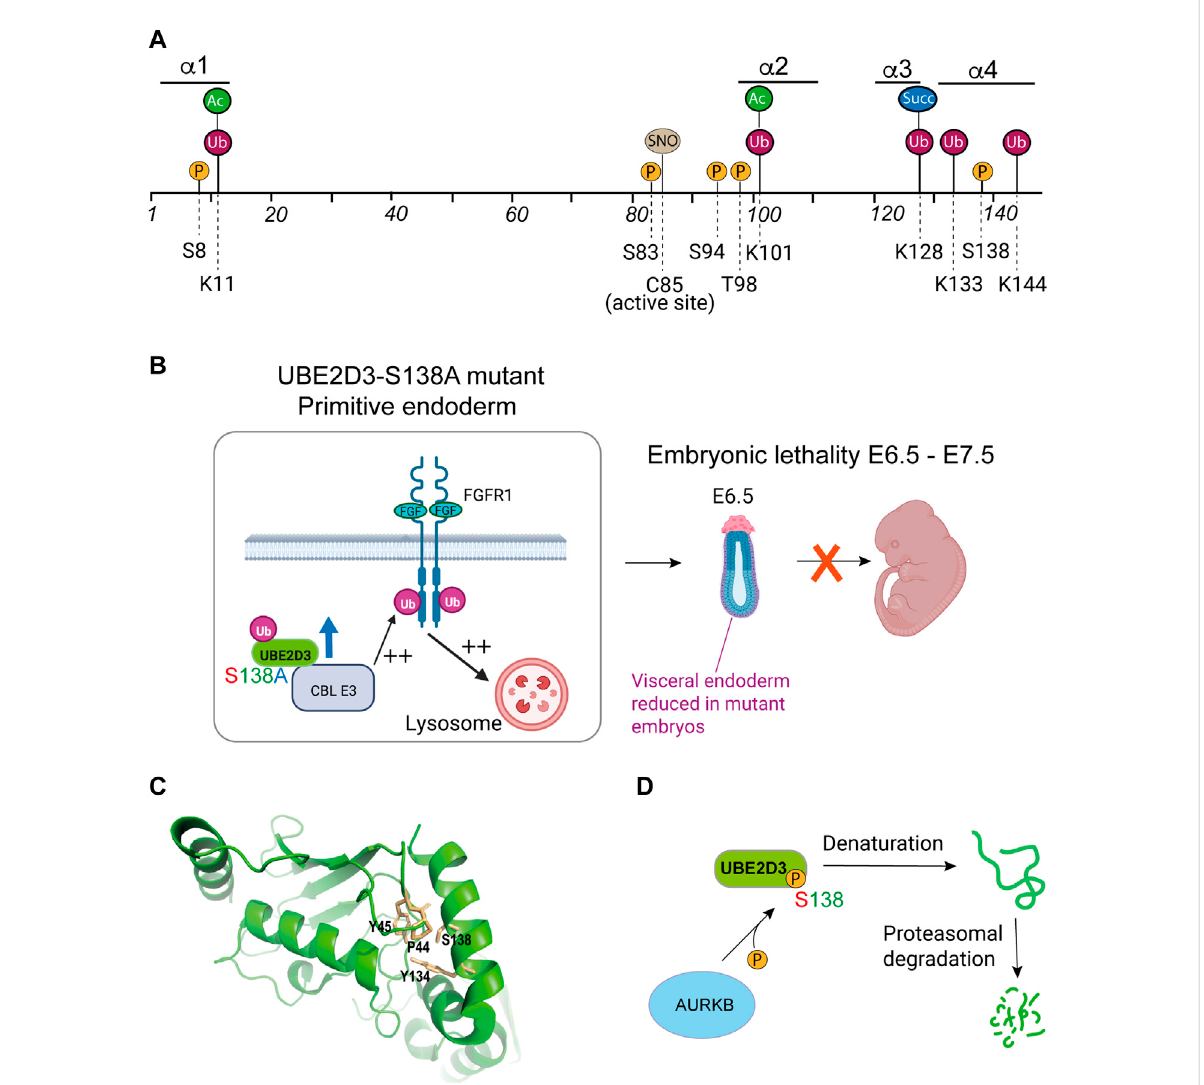
Role of post-translational modi fi cations (PTMs) in the regulation of UBE2D enzymes. (A) Residues in mammalian UBE2D that have been shown tobetargetsforPTMs.P=phosphorylation;Ub=ubiquitination;Ac=acetylation;Succ=succinylation;SNO=S-nitrosylation.Numbersindicatethe positions ofaminoacidresidues.InformationonPTMswasobtained fromPhosphoSite ® (Hornbecketal.,2015),withtheexceptionofS-nitrosylation of Cys85 (C85) (Valek et al., 2019; Fujikawa et al., 2020) and phosphorylation of UBE2D3-Ser138 (Roman-Trufero et al., 2020). (B) Phenotypic effects of the S138A mutation during early mouse development. Substitution of the amniote-speci fi c Ser138 residue with the alanine residue that is foundatthispositioninnon-amniotespeciesresultedina3-foldincreaseinthelevelofUBE2D3.Indevelopingprimitiveendoderm(PrE),thisresults in increased ubiquitination of fi broblast growth factor receptor 1 (FGFR-1) by the CBL E3 ligase, which uses UBE2D3 as a ubiquitin donor. EnhancementofFGFR1ubiqitinationcausesincreasedtraf fi ckingofthereceptortothelysosomeleadingtodownregulationofFGFR1signalling.This results in reduced levels of PrE and visceral endoderm and a high penetrance embryonic lethal phenotype between E6.5 and E12.5 . (C) Proximity of residues within the hydrophobic core of UBE2D3 to S138. Phosphorylation of S138 would be predicted to disrupt the interaction with these residues and destabilise the protein. Image was prepared by visualising PDB: 3UGB using PyMol (v2.5.4). (D) Schematic representation of the effect of phosphorylation of the amniote-speci fi c Ser138 residue by the Aurora B kinase on the stability of UBE2D3. Panels B and D created with